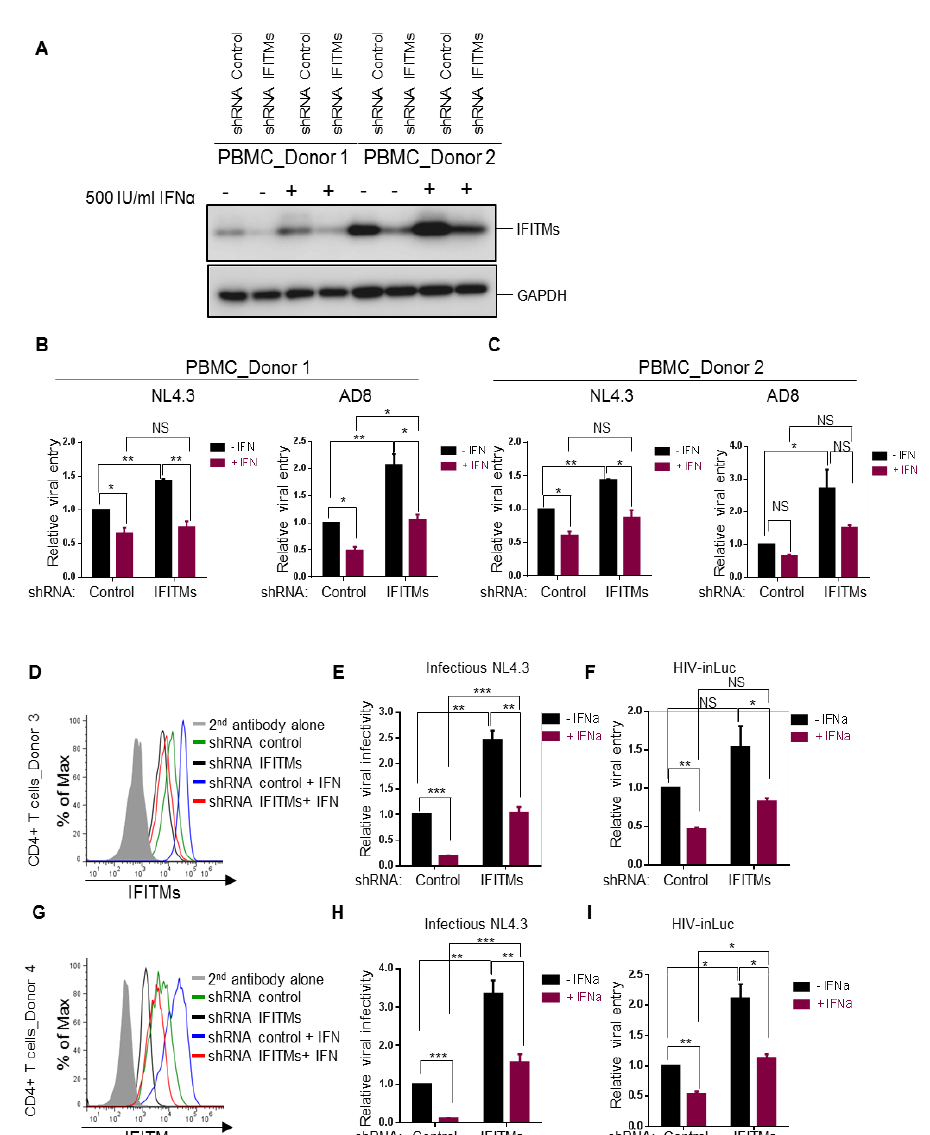
Figure 4. Effects of type I IFN and endogenous IFITM proteins on HIV-1 entry and replication in human PBMCs and CD4 + cells. ( A – C ) PBMCs from two healthy human donors were activated by 20 IU/mL IL-2 and 5 µg/mL PHAP for 3 days and were transduced with lentiviral shRNA control or pooled shRNA IFITMs for 24 h. Cells were then treated with 500 IU/mL IFNα 2b for 24 h or left untreated and were infected with HIV-inGluc bearing Env of NL4.3 or AD8 for 24 h before being collected for immunoblotting ( A ), or for measuring the luciferase activities ( B , C ). Relative entry was calculated by setting the luciferase activities of cells transduced by shRNA control pseudotypes and untreated with IFNα 2b to 1.0. Different comparisons were performed as indicated, with p values shown. ( D through I ) CD4 + T cells were isolated from PBMCs and transduced with lentiviral shRNA control or pooled shRNAs against IFITM1, 2 and 3. Cells were treated with 500 IU/mL IFN α for 24 h or were left untreated. The expression levels of IFITMs were determined by flow cytometry shown in ( D , G ) for two different donors. For replication assay, cells were infected with infectious NL4.3 ( E , H ) for 48 h and harvested virions were used to infect HeLa-TZM cells, with firefly luciferase activities being measured 24–48 h after infection. For one-round entry assay, cells were infected with HIV-inGLuc reporter viruses ( F , I ) and gaussia luciferase activities were directly measured from the harvested supernatants. Relative infectivity and relative entry were determined by setting the values of shRNA control and IFN α -untreated cells to 1.0. Data were mean ± SD of three experiments, each performed in duplicates; * p < 0.05, ** p < 0.01, *** p <